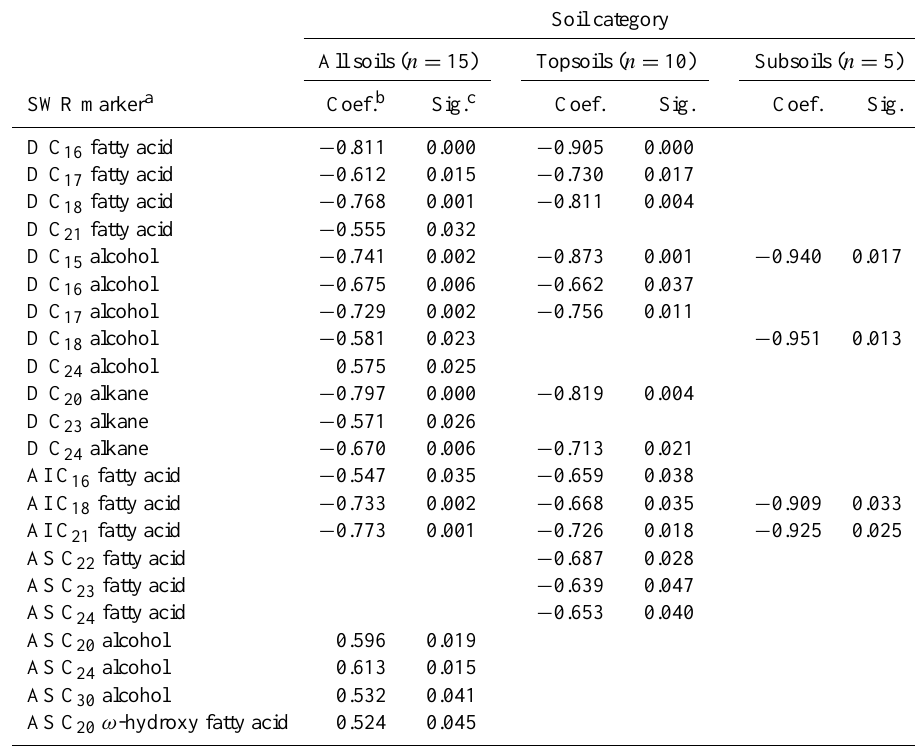
Table 2. The relative concentrations (log (µgg − 1 TOC)) of single SWR markers significantly related to SWR. Soil category All soils ( n = 15) Topsoils ( n = 10) SWR marker a Coef. b Sig. c Coef. Sig.